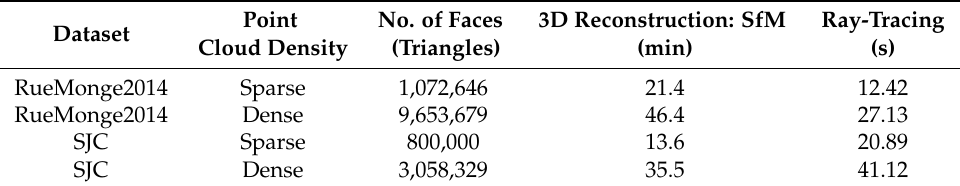
Table 6. Ray-tracing performance for geometry classification.